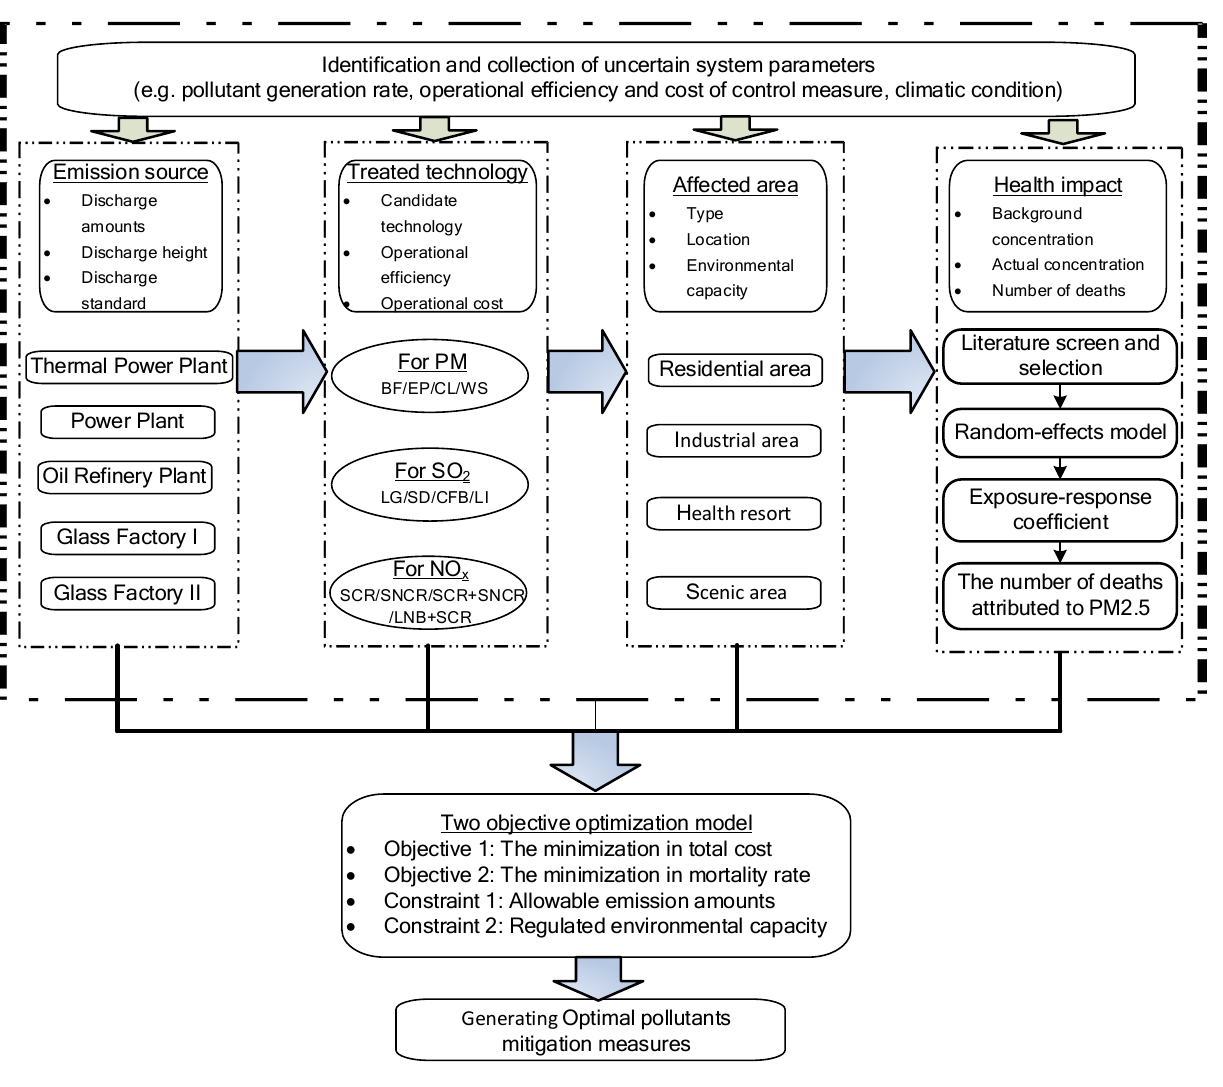
Figure 3. A schematic of the air quality management system in the Nanshan district.